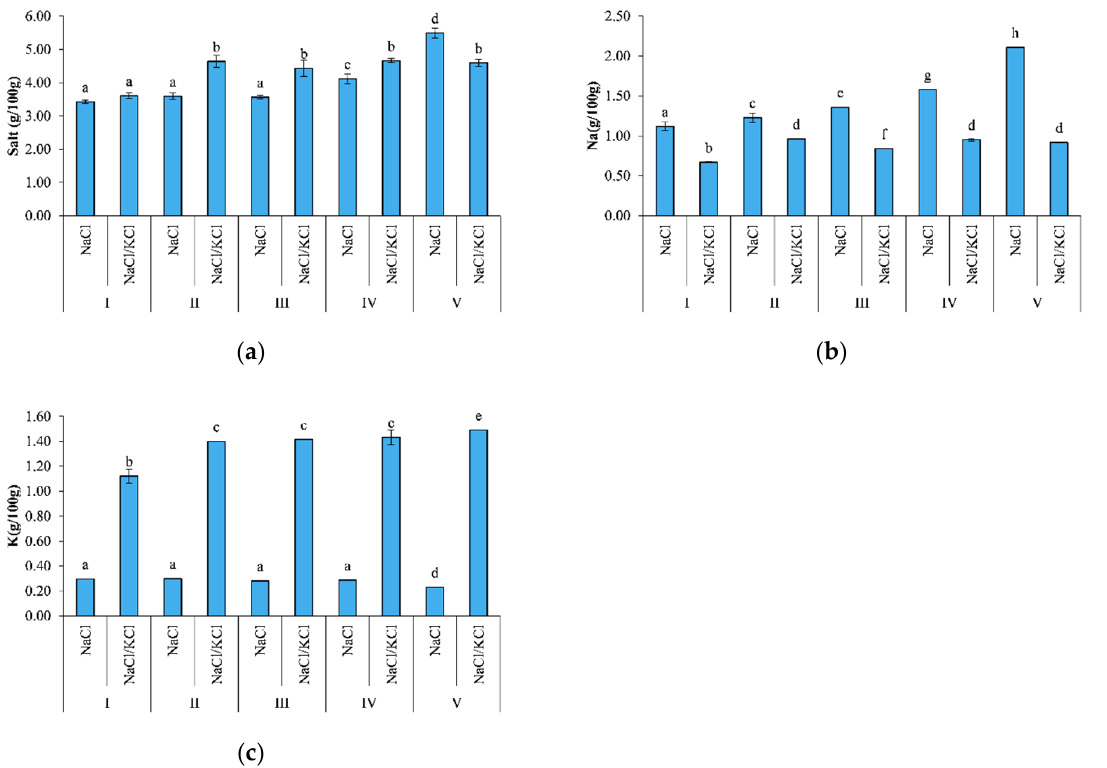
Figure 2. Salt, Na, and K determined in the smoked fillets of D. labrax , in the five smoking processes (I, II, III, IV, V). Different letters (a, b, c…) indicate significant differences ( p < 0.05). ( a ) Salt content; ( b ) Na content; ( c ) K content.